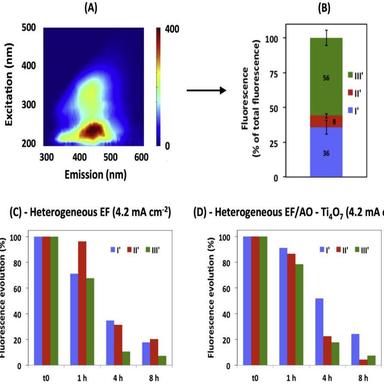
Fluorescence evolution of the NF concentrate effluent treated by EAOPs, as a function of time treatment. Zone I': colloidal proteins; zone II': Soluble Microbial by-Product (SMP)-like fluorophores; zone III': Humic and Fulvic acids (HA þ FA)-like fluorophores.